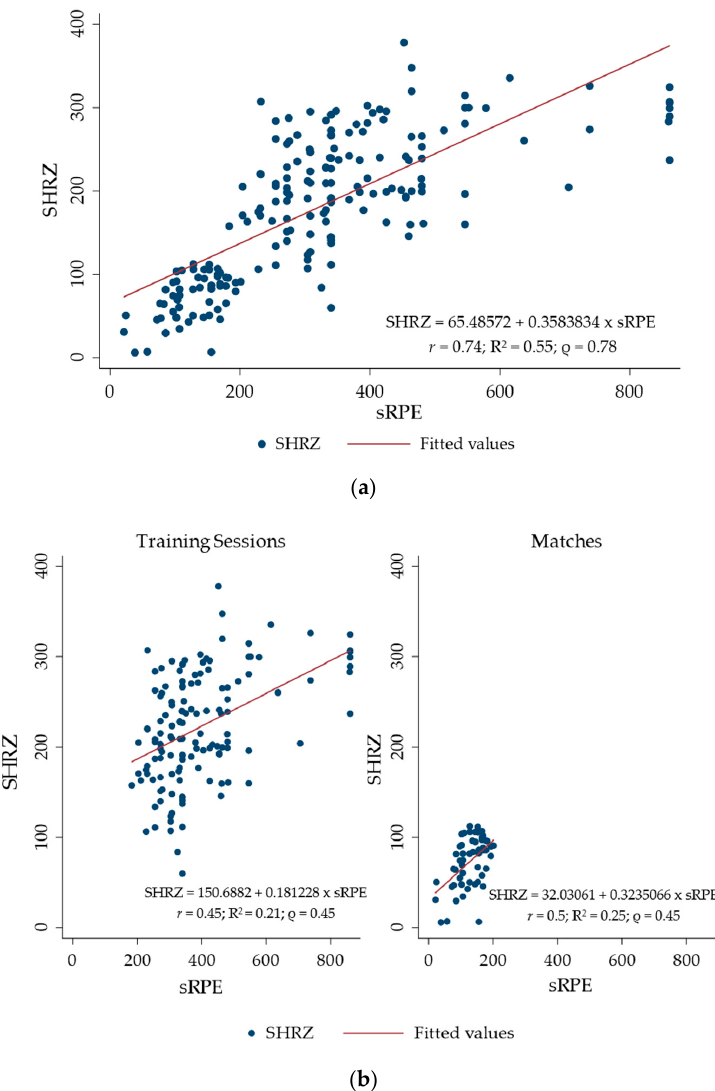
Figure 1. Relationship between the Summated Heart Rate Zone (SHRZ) (y axis) and session Rating of Perceived Exertion (sRPE) (x axis) for all sessions ( a ) and for training sessions and matches separately ( b ). Table 2. Comparison of Linear Mixed Models developed for the whole sessions.